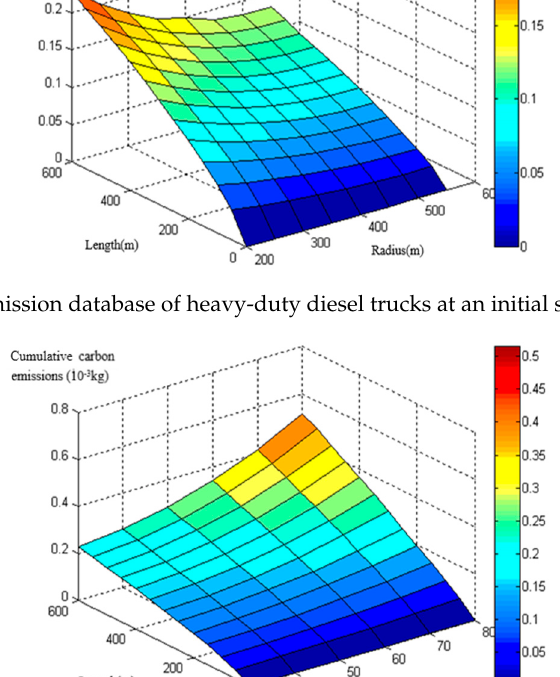
Figure 4. 𝑇 (cid:3036) with a radius of 200 m.